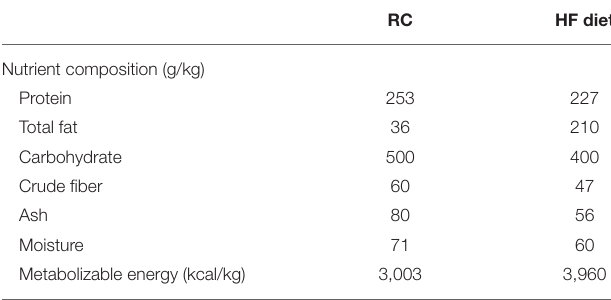
TABLE 1 | Composition of the